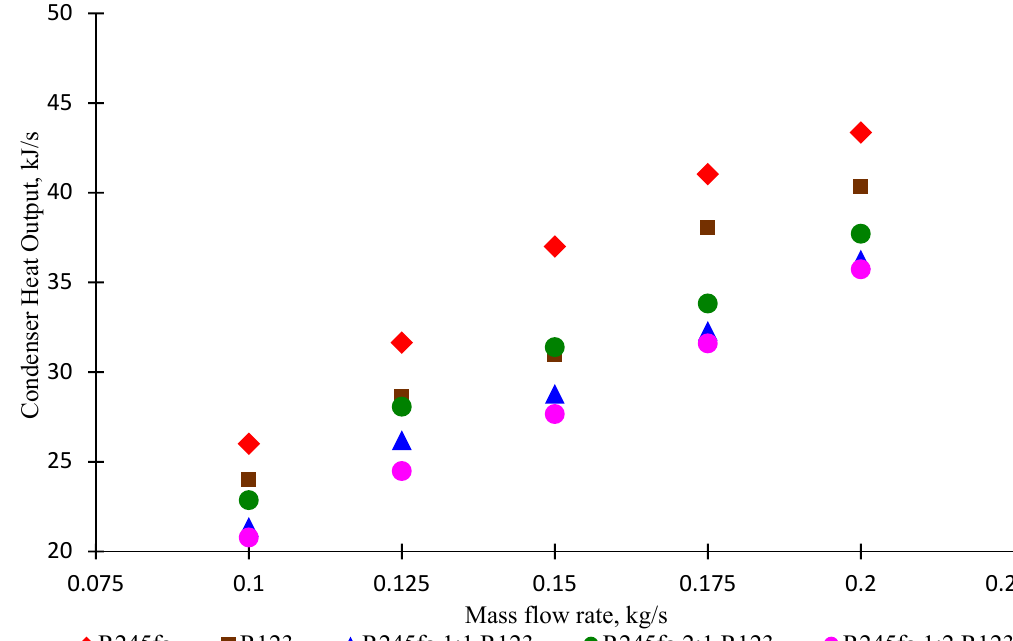
Figure 13. Condenser heat output as a function of mass flow rate for R245fa, R123, and mixed working fluids with heat source at 110 ° C.